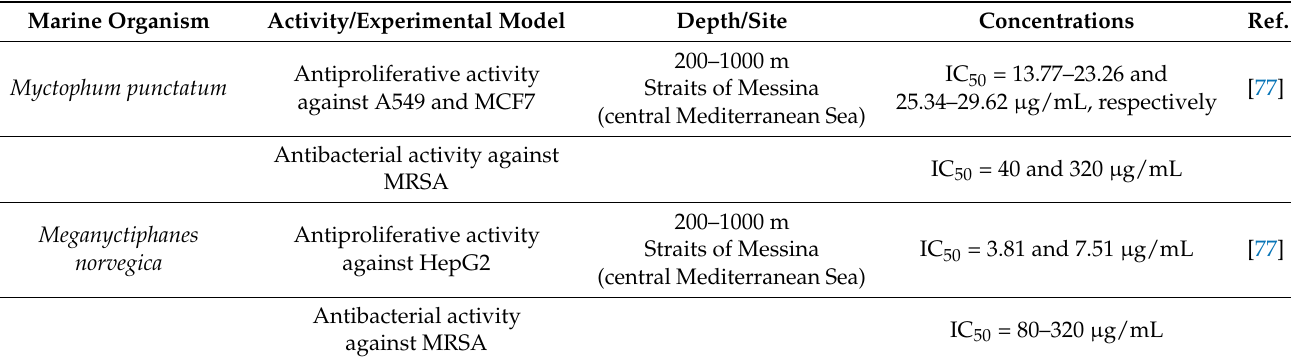
Table 5. Bioactive compounds from deep-sea mesopelagic organisms.